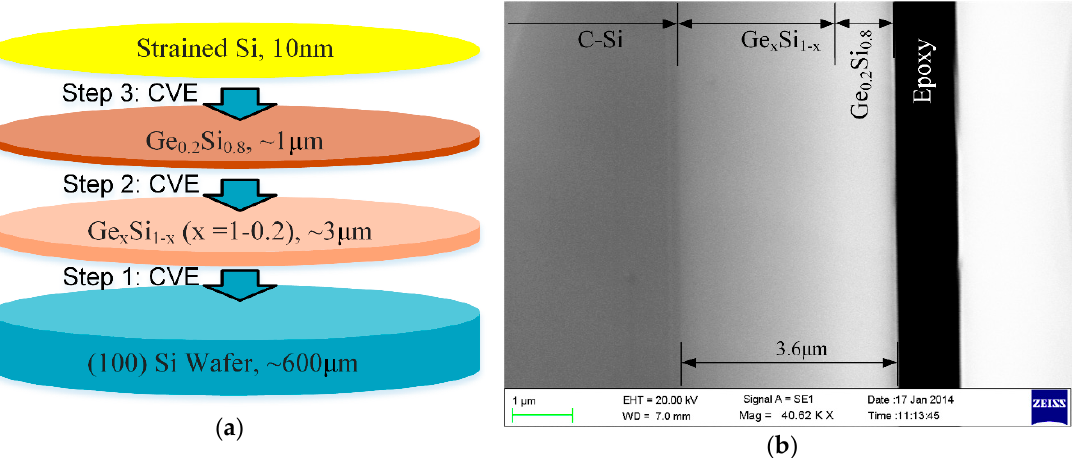
Figure 1. ( a ) Schematic structure of prepared ε -Si/GeSi/C-Si material, ( b ) scanning-electron microscopy (SEM) image of multilayer vicinity of sample cross-section. CVE, chemical vapor epitaxy.